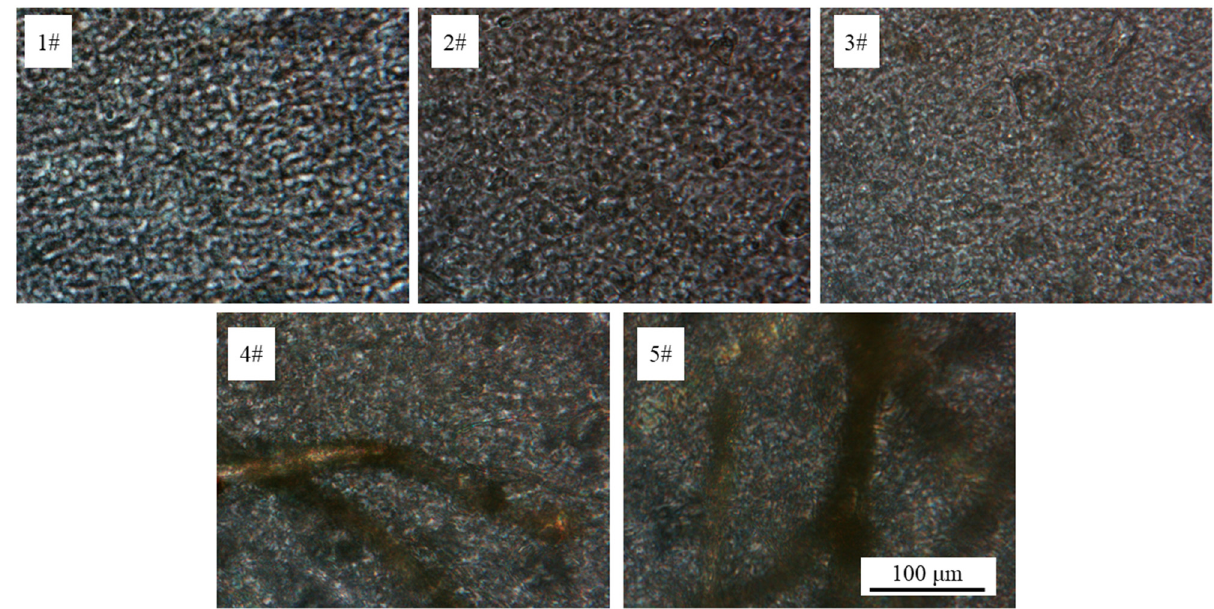
Figure 5: POM images of HDPE